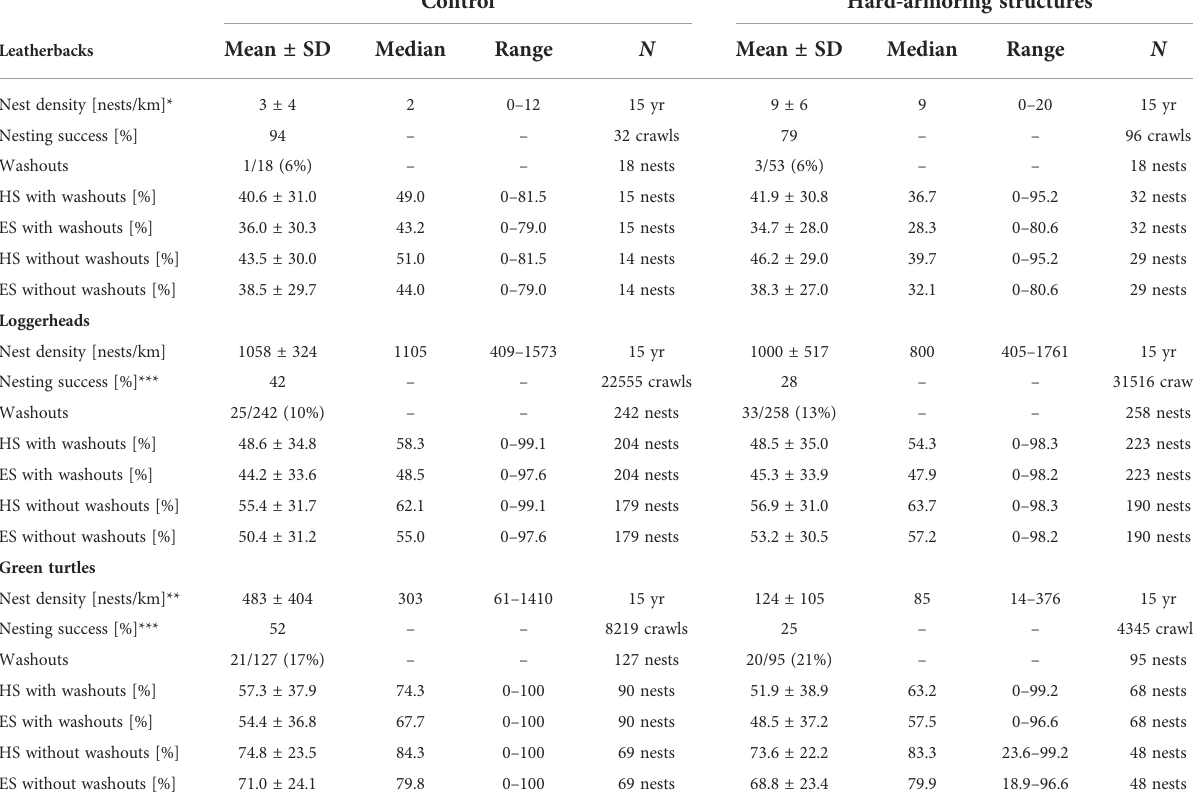
TABLE 1 Nest density, nesting success, washouts, and hatching success (HS) and emergence success (ES) with and without washouts of leatherback ( Dermochelys coriacea ), loggerhead ( Caretta caretta ), and green ( Chelonia mydas ) sea turtles nesting at the control site in comparison to the hard-armoring structures on Tequesta and Jupiter Inlet Colony Beaches, Florida, USA from 2007 – 2021.